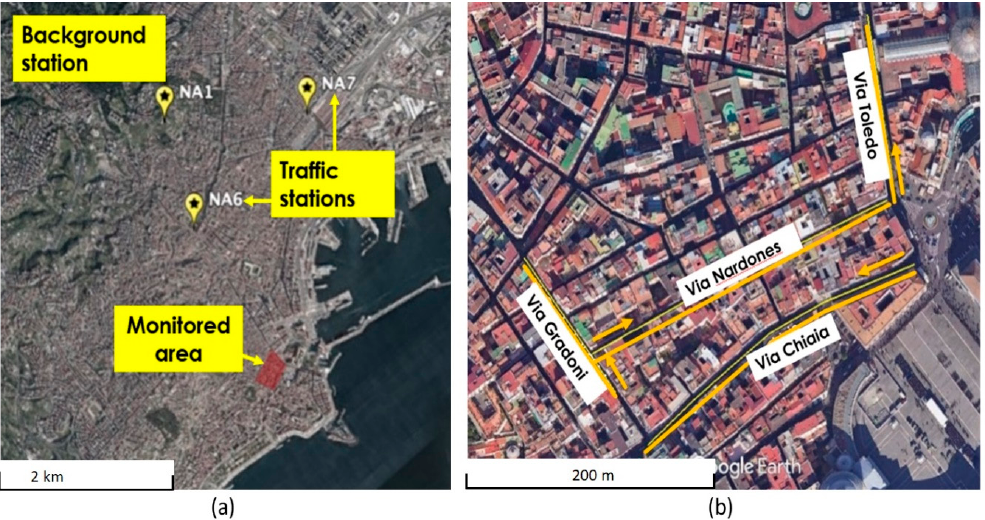
Figure 1. Map of Naples showing the location of the monitored area and of the fixed stations belonging to the air quality network ( a ). Zoomed-in view of the monitored area with the four streets ( b ). The monitoring campaign lasted for 4 days—7, 20, 25 November and 7 December 2019.